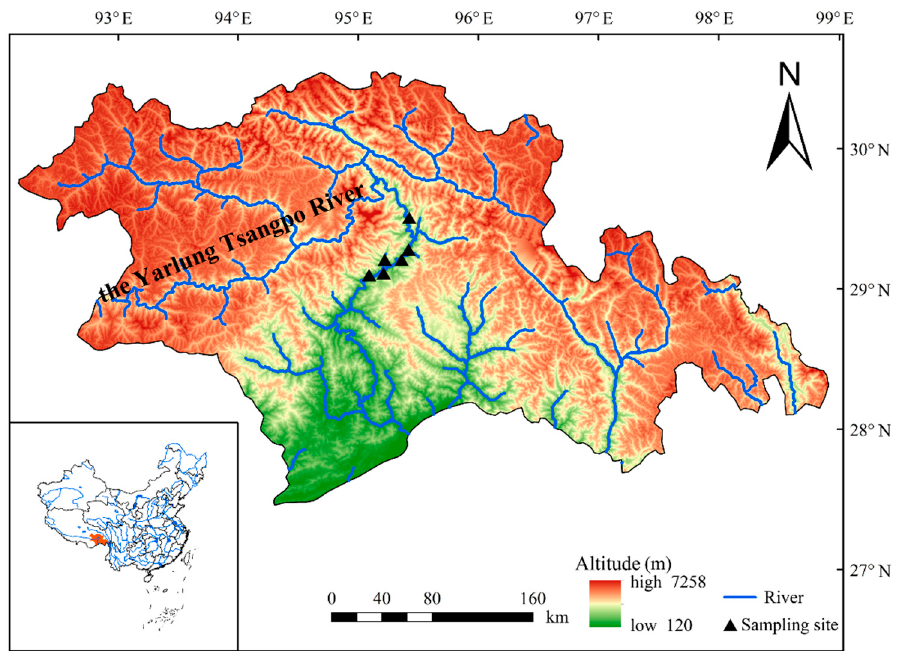
Figure 1. Map showing the sampling sites of G. tibetana in the lower Yarlung Tsangpo River.